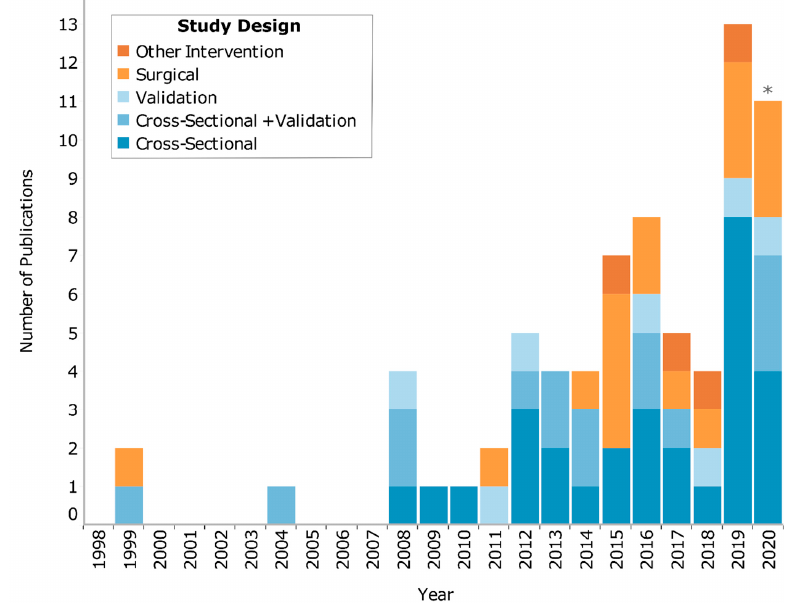
Figure 2. Number of included studies published each year, grouped by study (* up to June 2020). An interactive version of this figure which highlights the referenced studies can be found at: https://public.tableau.com/profile/dylan.kobsar#!/vizhome/WearableOAReview_Story/Fig2_Fig3_Story